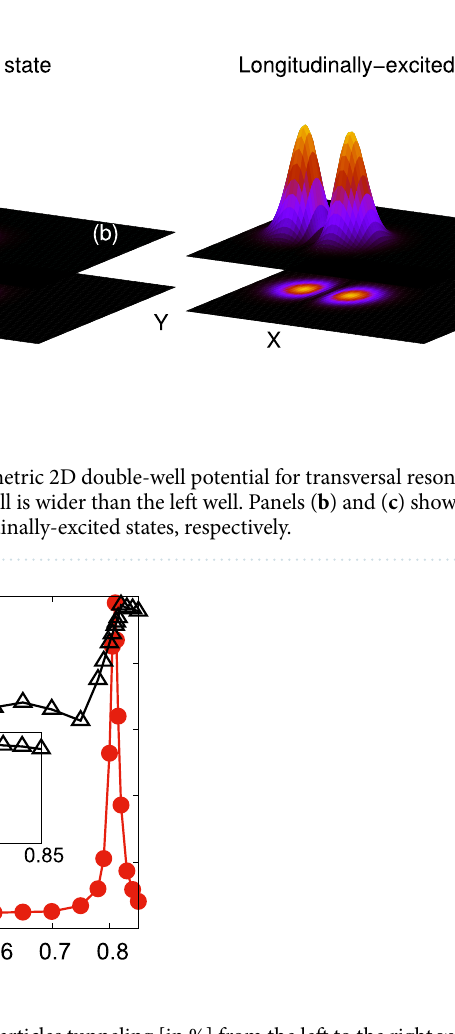
Figure 9. Variation of the maximal number of particles tunneling [in %] from the left to the right well with the trapping frequency ω n of the right well for (cid:31) G and (cid:31) X (see Fig. 1b). The interaction parameter is � The same plot is highlighted in the inset by enlarging the resonance region. The data is generated from the time- dependent solution of the Gross-Pitaeveskii equation. We show here dimensionless